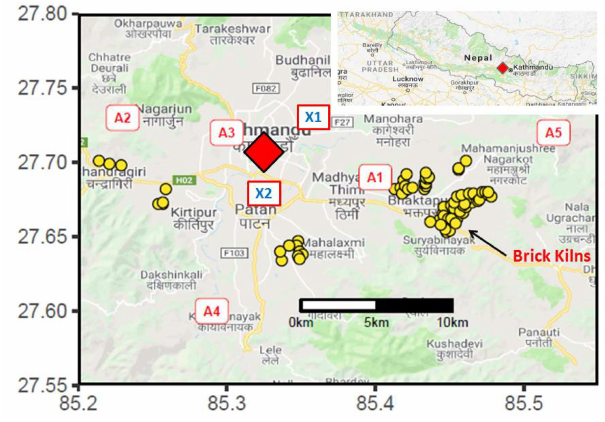
Figure 1. Observation sites in the SusKat-ABC international air pollution campaign during 2013–2014 in the Kathmandu Val- ley. A1 = Bode, A3 = Paknajol and A4 = Naikhandi were selected within the valley floor and A2 = Bhimdhunga and A5 = Nagarkot on the mountain ridge. Naikhandi site is also near the Bagmati River outlet. Past study sites, Bouddha (X1) and Pulchowk (X2), which are referred in the paper, are also shown in the figure. Source: Google